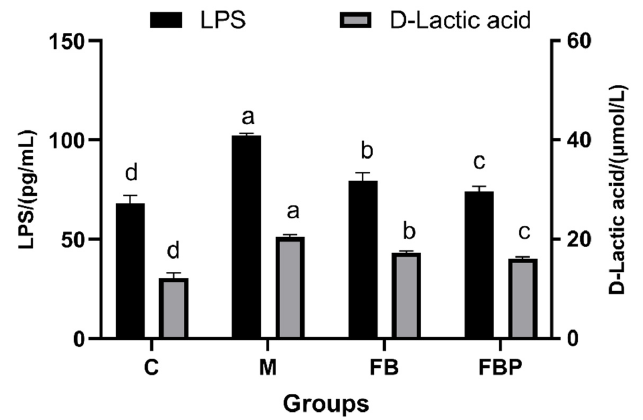
Figure 4. Effect of different intervention groups on the integrity of the intestinal barrier in rats. C: Control; M: Model; FB: Fermentation broth; and FBP: Fermentation broth with prebiotics. a, b, c, d indicates a significant difference between groups ( p < 0.05).